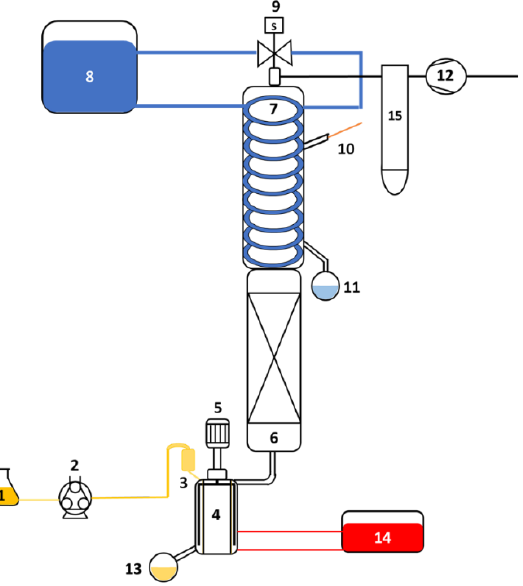
Figure 2. Simplified schematic of the fractional distillation equipment: (1) essential oil tank; (2) peristaltic pump; (3) feed; (4) evaporator; (5) motor; (6) packed column; (7) condenser; (8) condenser cooling system; (9) solenoid valve; (10) thermometer; (11) distillate collector; (12) vacuum pump; (13) residue collector; (14) heating system; and (15) trap vacuum.